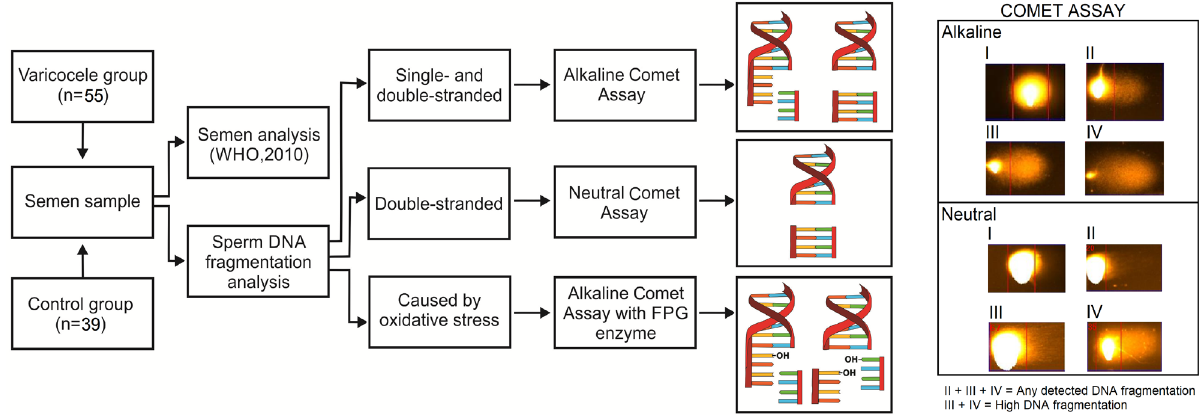
Figure 1 - Study design, including all performed sperm DNA fragmentation tests, as well as the type of fragmentation detected in each of these tests. Right panel: representative images of cell classification, both for alkaline assays and neutral comet assay. Class I - High DNA integrity (no DNA migration); Class II - Low DNA fragmentation (an intense nucleus with little DNA migration); Class III - Increased DNA fragmentation (an observed nucleus, but with intense DNA migration); Class IV - High DNA fragmentation (an intense DNA migration and no observed nucleus). FPG - DNA glycosylase formamidopyrimidine